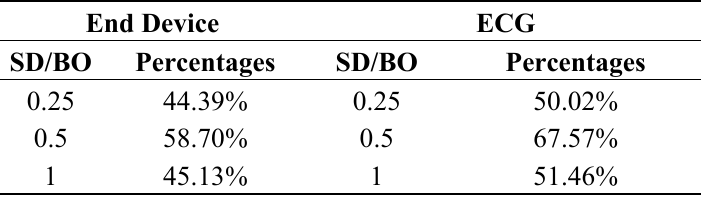
Table 10. Percentage of Packages that received ACK on the first attempt BO =